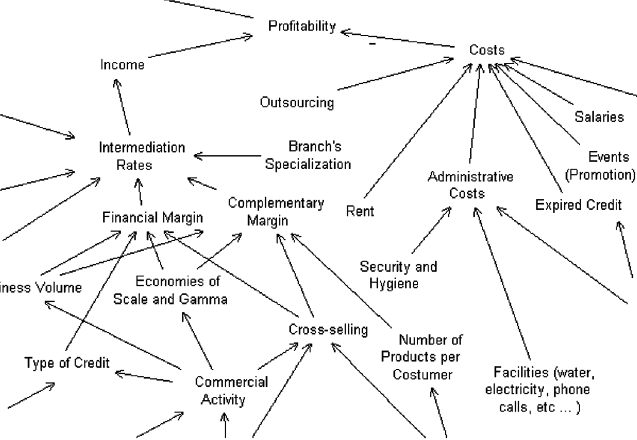
Fig. 1. Part of the strategic map Source: Adapted from Ferreira et al. (2011a: